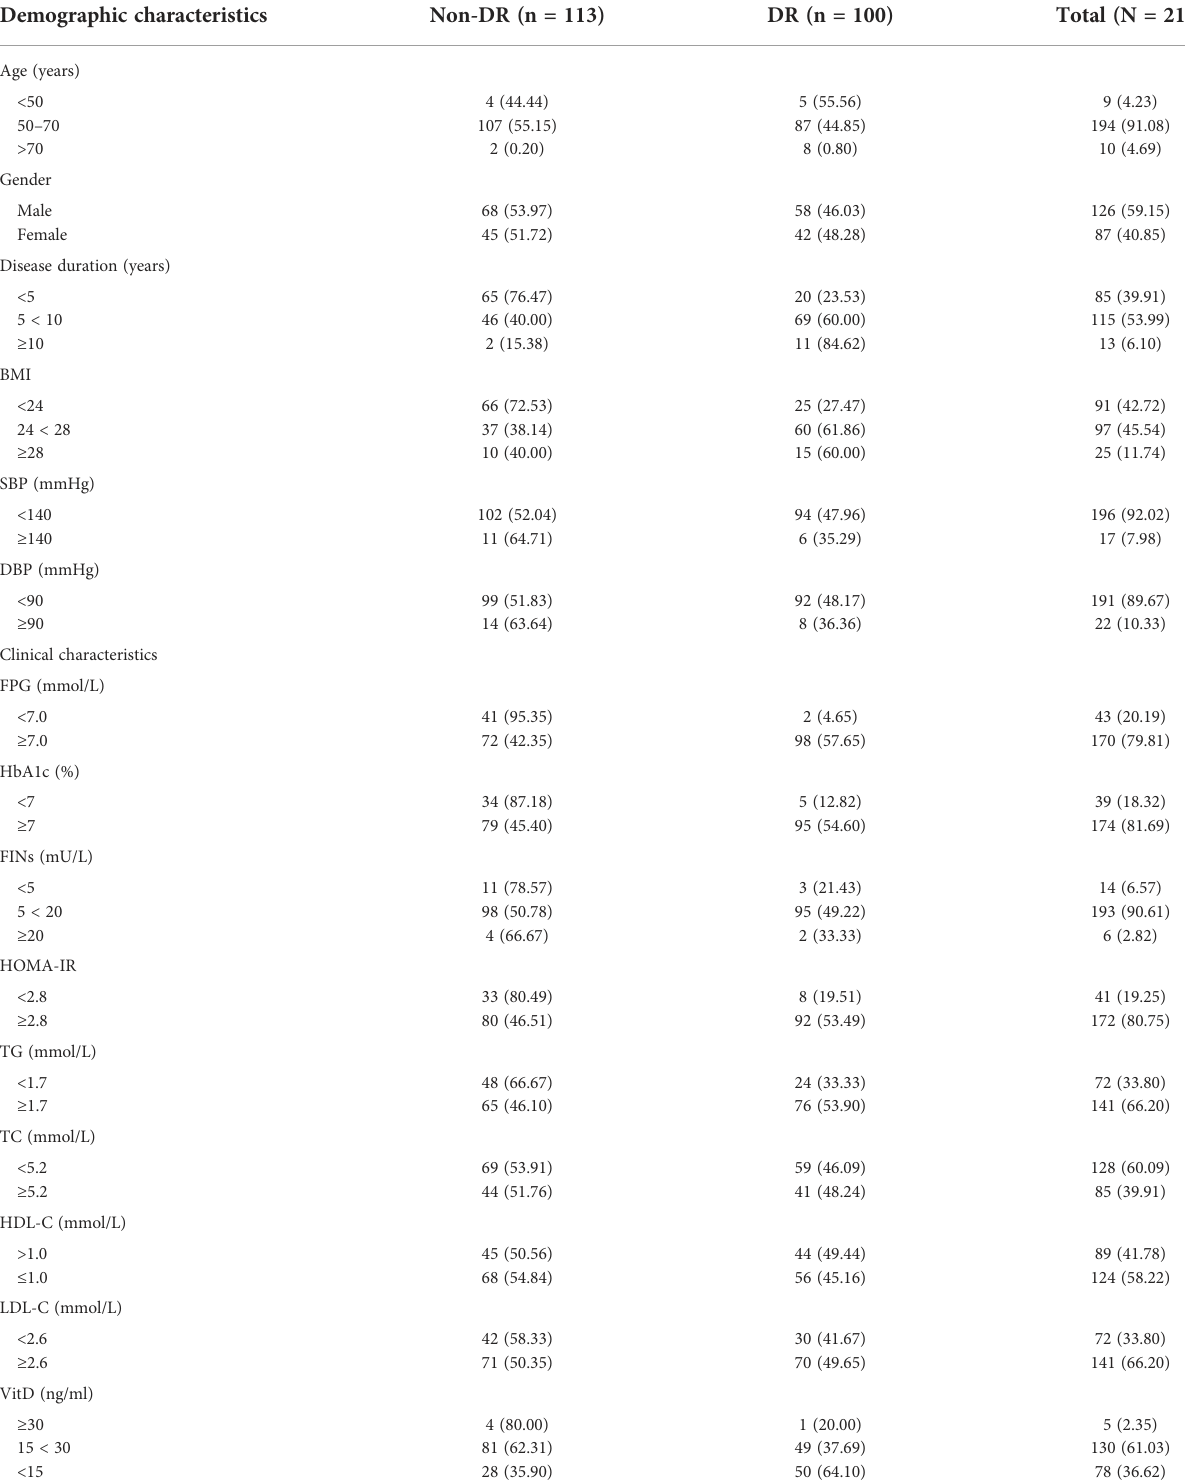
TABLE 1 Differences between demographic and clinical characteristics of the non-DR and DR